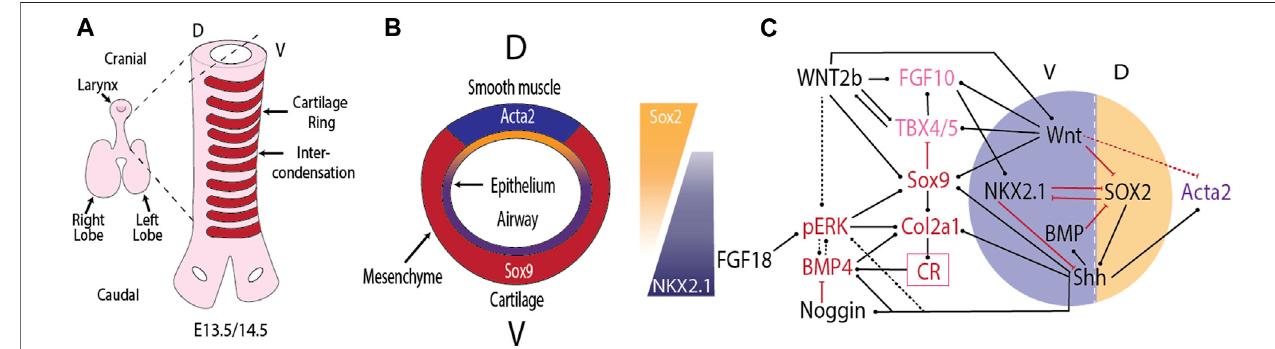
FIGURE 1 | Tracheal cartilage ring formation. (A) Cartilage rings (red) emerge in the mesenchyme on the ventral (V) side of the trachea. (B) Cross-section of the developing trachea. (C) Regulatory interactions that control the emergence of cartilage rings (CR) in the ventral and airway smooth muscle in the dorsal (D) tracheal mesenchyme. Black arrows indicate positive regulation, red arrows negative regulation. For details see